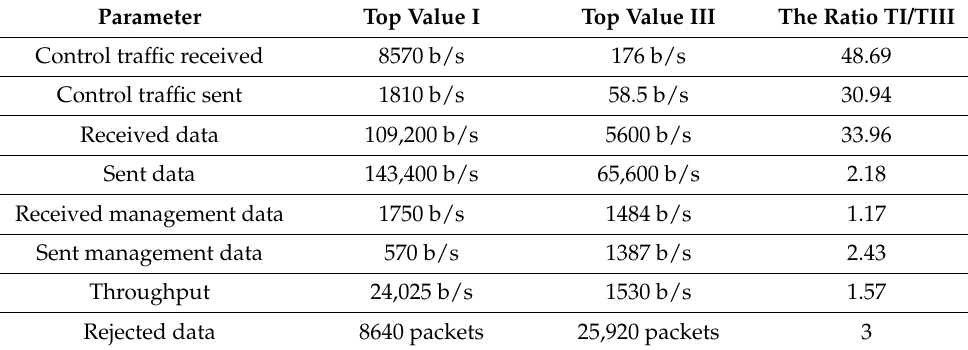
Table 7. The statistics of the network operation in scenarios I and III.